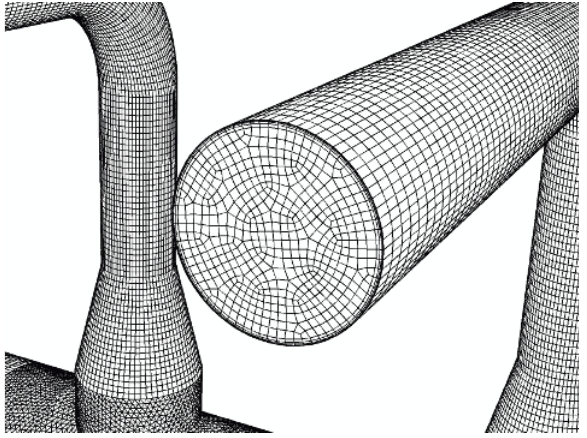
Figure 5: Surface mesh of the metering